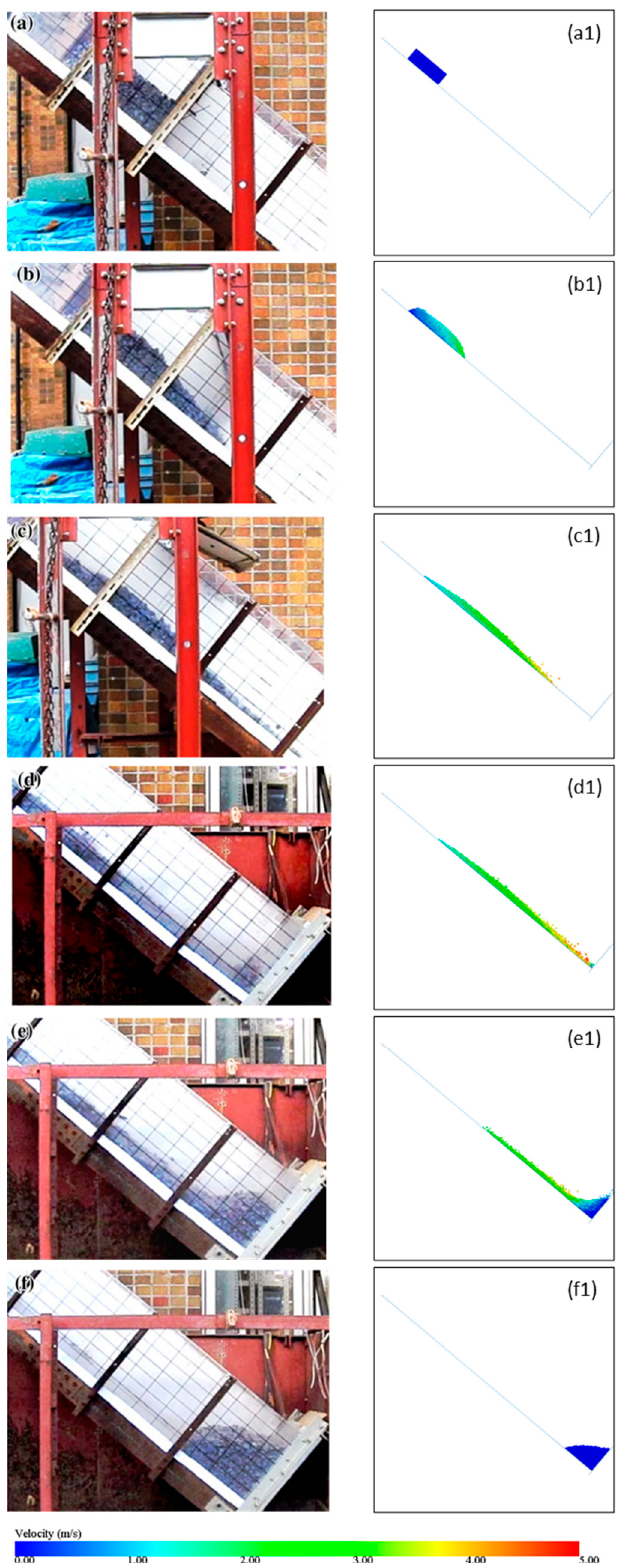
Figure 2. Comparison of flow and deposition morphology between physical and experimental results [14]: ( a – f ) obtained by us and DEM simulation results ( a1 – f1 ).